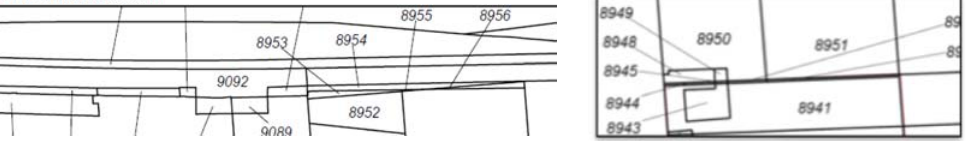
Figure 1. Registration of multi-level ownership on 2D parcels results in fragmented parcel patterns.